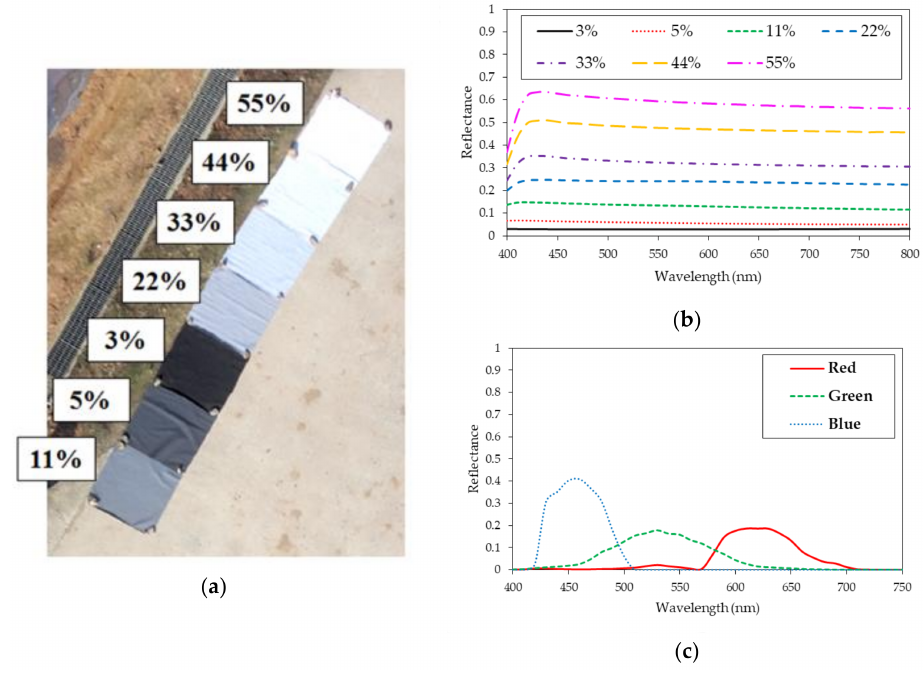
Figure 3. ( a ) View of the calibration targets placed in the test field; ( b ) standard reflectance spectrum of the calibration targets measured with the field spectrometer; ( c ) spectral response of the red, green and blue (RGB) camera.